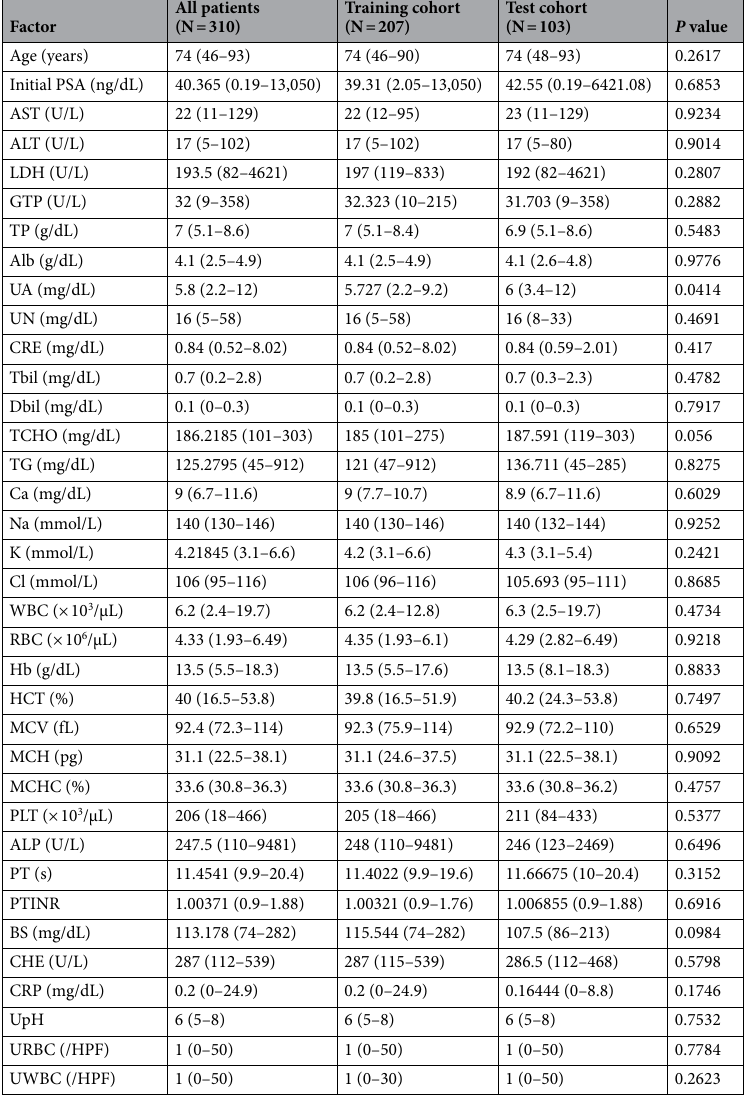
Table 2. Characteristics of analysis factor. The data in the brackets indicate a range of